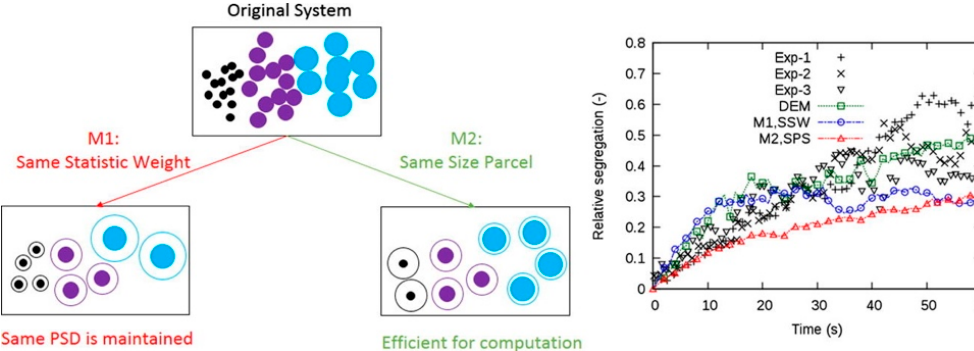
Figure 11. Coarse graining strategies to deal with polydisperse solids. Reprinted from [71], with permission from Elsevier.